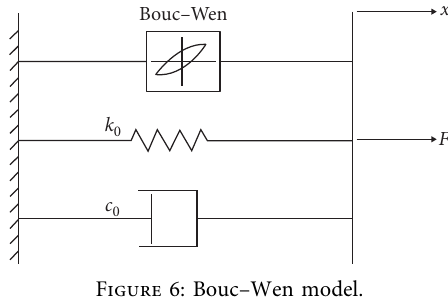
Figure 6: Bouc–Wen model.